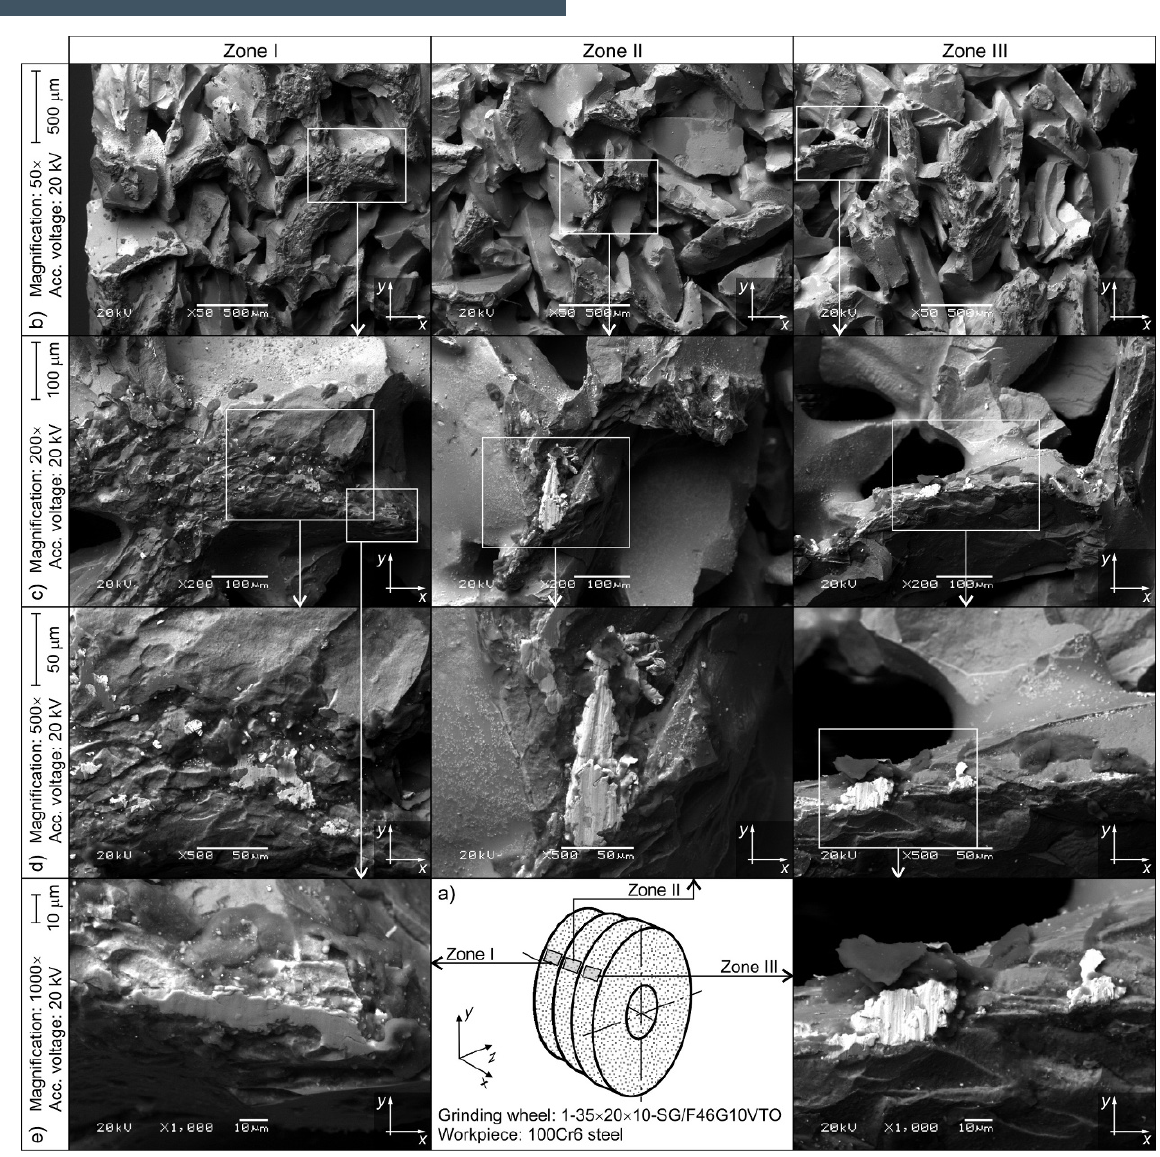
Figure 5. SEM microphotographs of the active surface of the grinding wheel with zones of various diameters (zones I–III) after internal cylindrical plunge grinding of 100Cr6 steel: a) construction scheme of the tool; b) mag. 50 × ; c) mag. 200 × ; d) mag. 500 × ; e) mag. 1000 ×